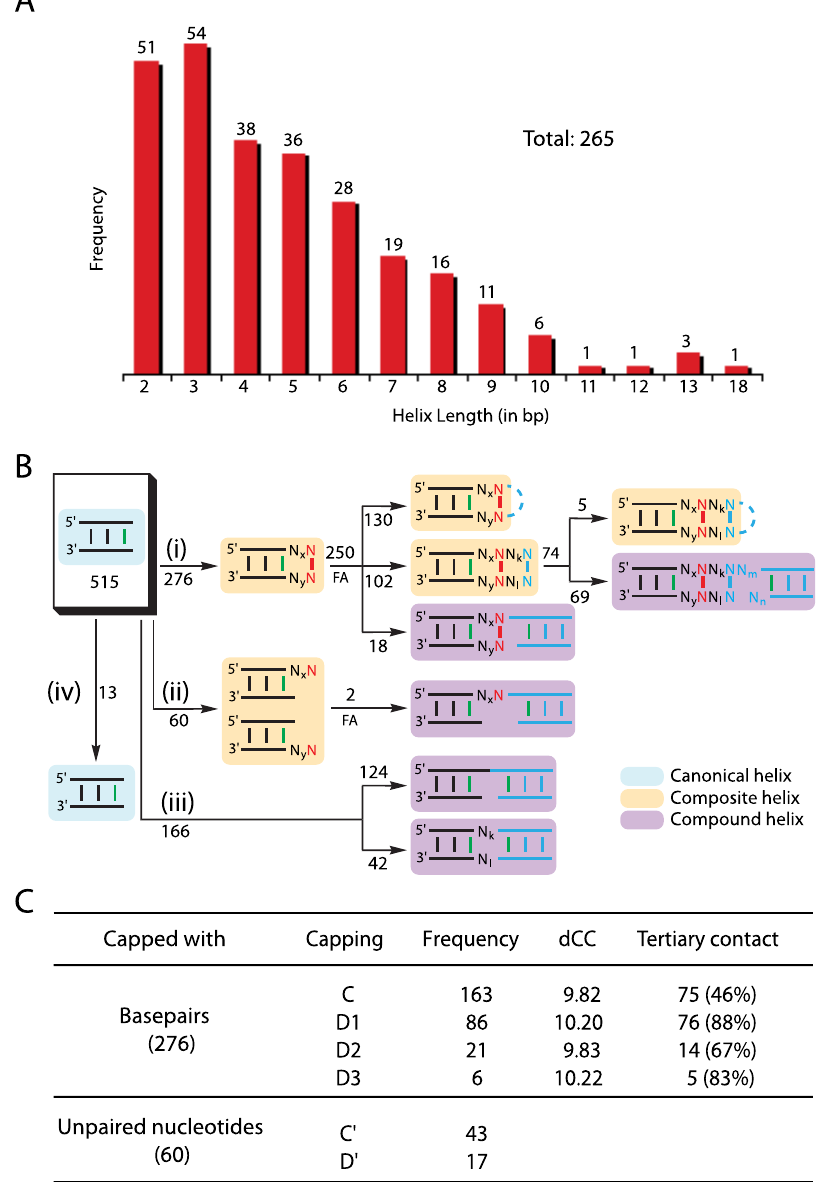
Figure 1. C’nonical helices found in T16S and H23S rRNAs and their end-stacking. ( A ) Distribution of canonical helix lengths. ( B ) Schematic representation of topological end-stacking of canonical helices, where x and y refer to the numbers of the intervening nucleotides between a canonical helix and a helix capping motif. While helix ends are shown in green and helix capping motifs in red, the 3 9 - and 5 9 -IVS are denoted with N x and N y , respectively, where N={A, C, G, U}. ( i ) Capping with basepairs: C-capping if x =0 and y =0; D1-capping if x =0 and y . 0; D2-capping if x . 0 and y =0; D3-capping if x . 0 and y . 0. ( ii ) Capping with unpaired nucleotides: C 9 -capping if x =0 or y =0; D 9 -capping if x . 0 or y . 0. ( iii ) Coaxial stacking without any ‘‘bridging’’ cap. ( iv ) Canonical helices not involved in any type of end-stacking. Further association (FA) to the loop side with additional unpaired nucleotides, basepairs, and other canonical helices are shown in cyan dotted lines, cyan basepairs, and cyan helices, respectively. Each of x, y, k, l, m, and n is any integer greater than or equal to zero. ( C ) Distribution of helix capping motifs and their involvement in tertiary contact.